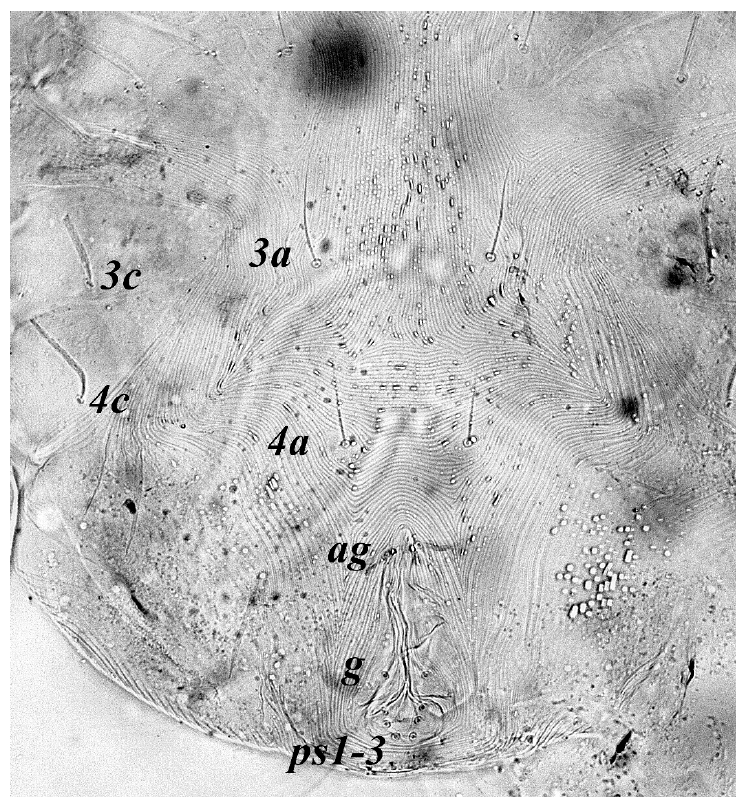
Figure 28. Neophyllobius lorestanicus Female. Venter.